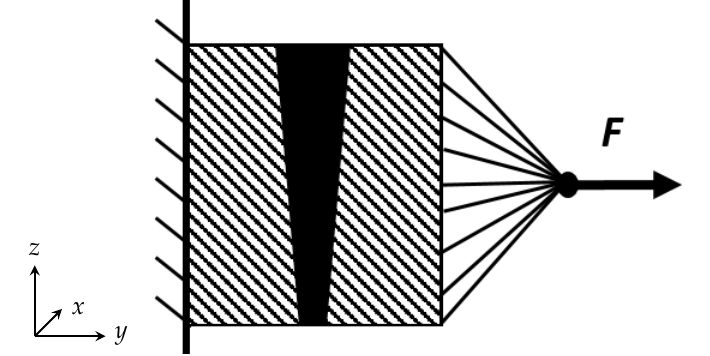
Figure 4. Cross sectional view on the geometry of the simulation